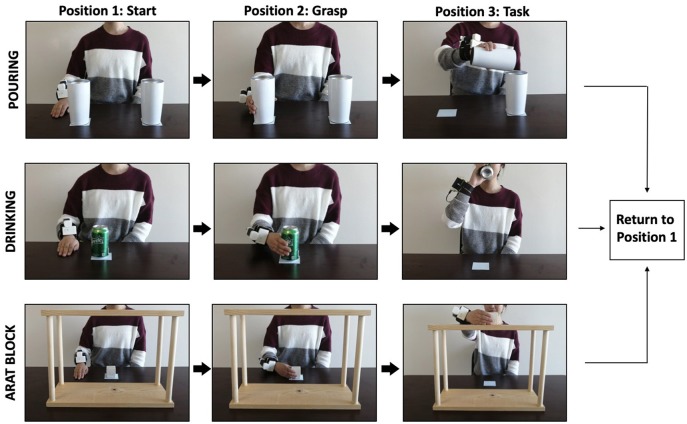
Example of a participant executing the pour water (top panel), drink (middle panel), and block task (bottom panel) while wearing the outREACH sensor.